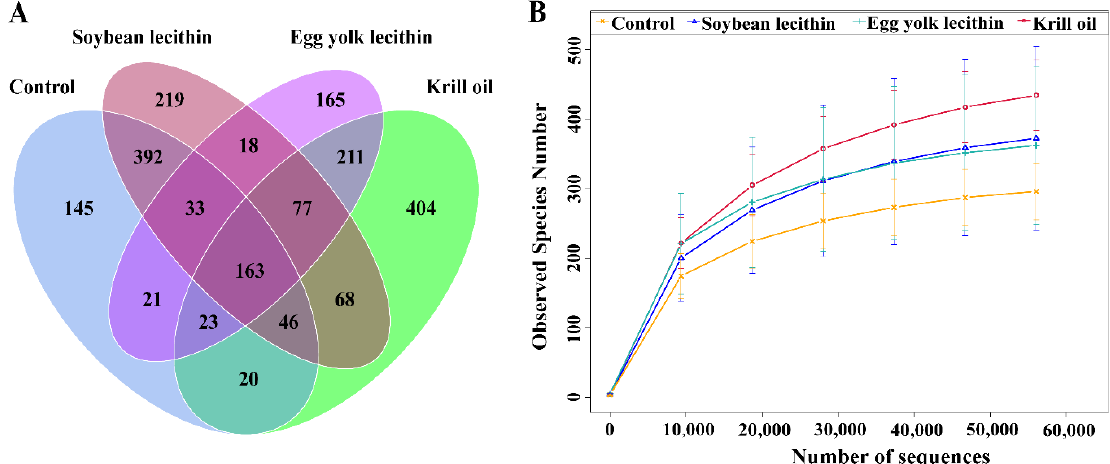
Figure 4. Gut microbial community analysis of female L. vannamei fed with different phospholipids. ( A ) Venn diagram indicating the number of unique and shared OTUs. ( B ) Rarefaction curve indirectly reflecting the richness of bacteria in each treatment group.